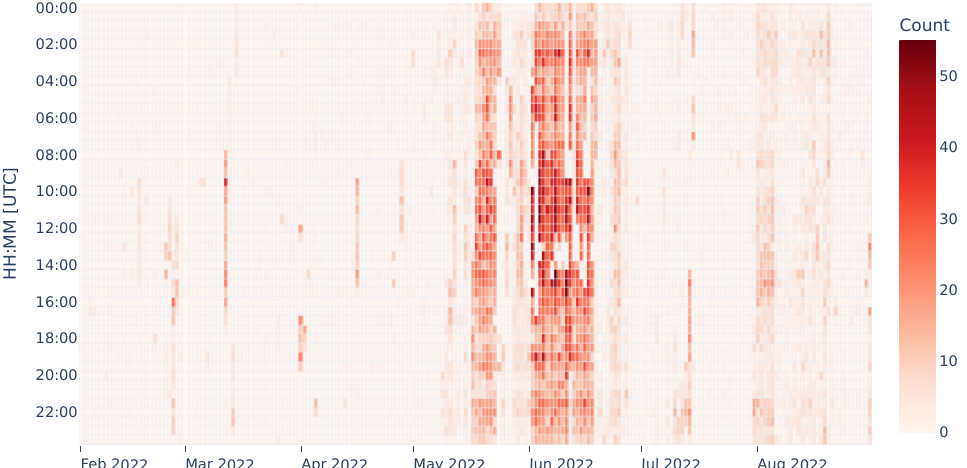
Figure 4. Number of flights influenced by RFI activities per 30-min interval over the entire observation period. The colour varies as a function of the number of flights affected by RFI for the corresponding 30-min